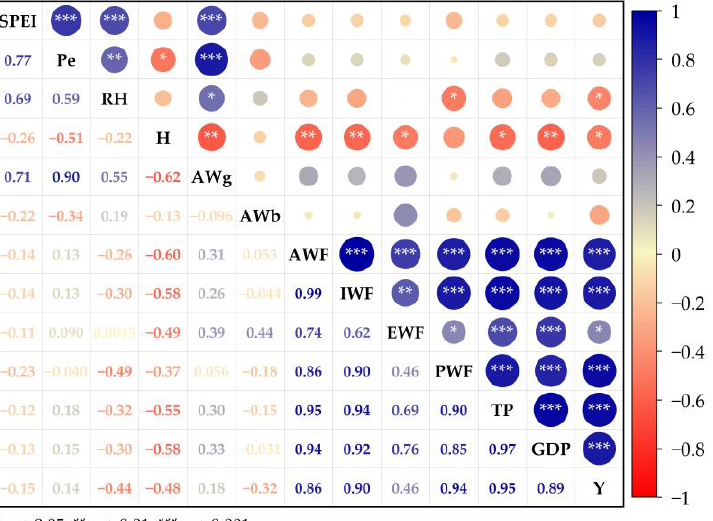
Figure 9. Correlation test between the elements (SPEI, Pe, Relative Humidity (RH), Sunshine hours (H), AWg, AWb, AWF, IWF, EWF, PWF, TP, GDP, Y).